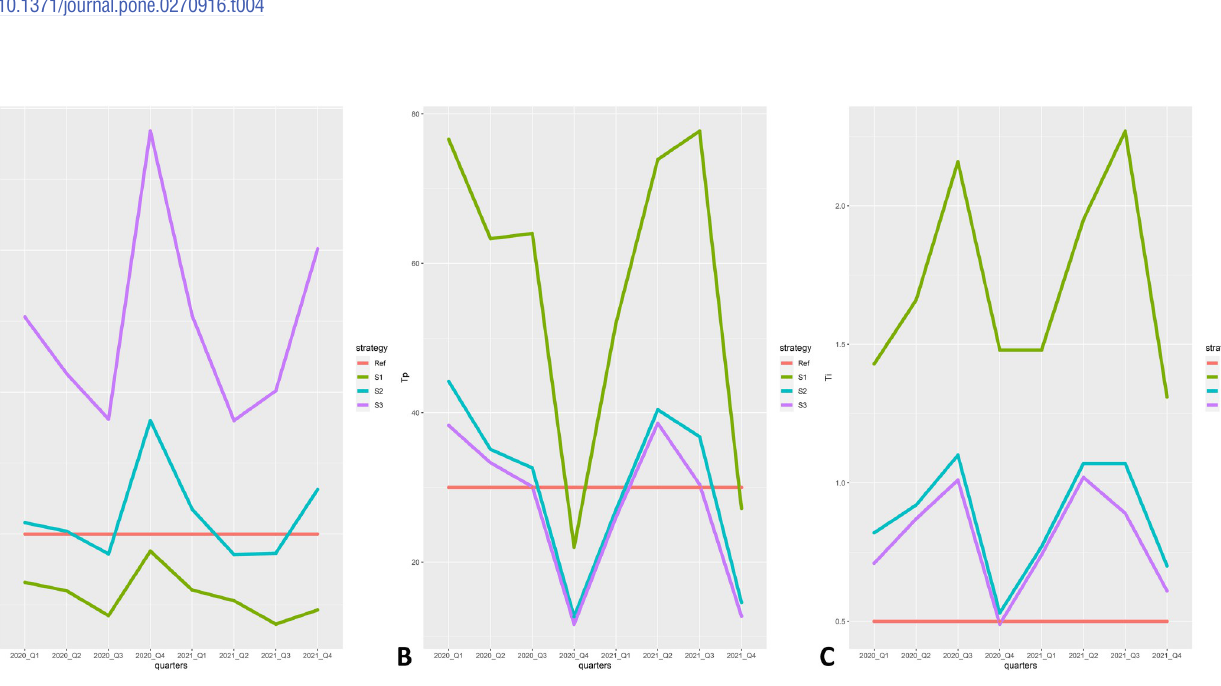
Fig 3. Comparison of the effectiveness index for packed red cell preparation among strategies by quarters. (A) Crossmatch to transfusion ratio, (B) transfusion probability, (C) transfusion index. Abbreviations: C/T ratio = Crossmatch to transfusion ratio, Ti = transfusion index, Tp = transfusion probability, Ref = effectiveness criteria for each index, S1 = Machine learning-based strategy, S2 = Clinical trial-based strategy, S3 = Routine-based